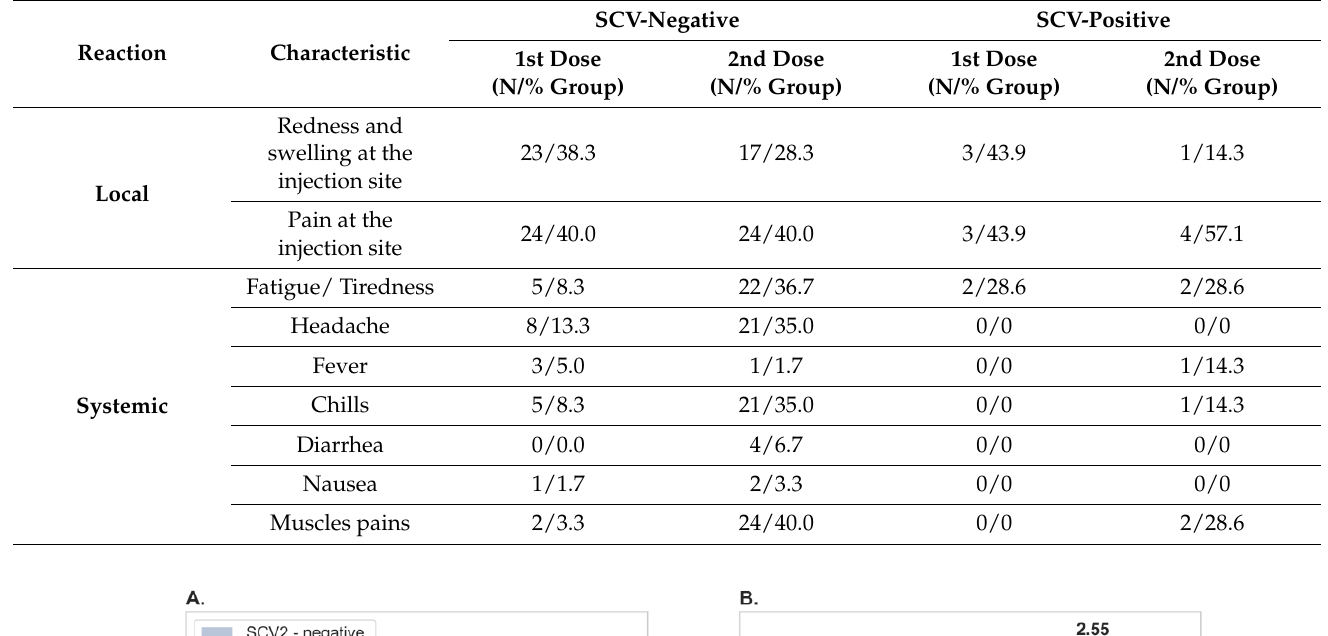
Table 3. The number of self-reported local and systemic effects, in SCV2-negative and SCV2-positive groups, after the first and second vaccine dose.